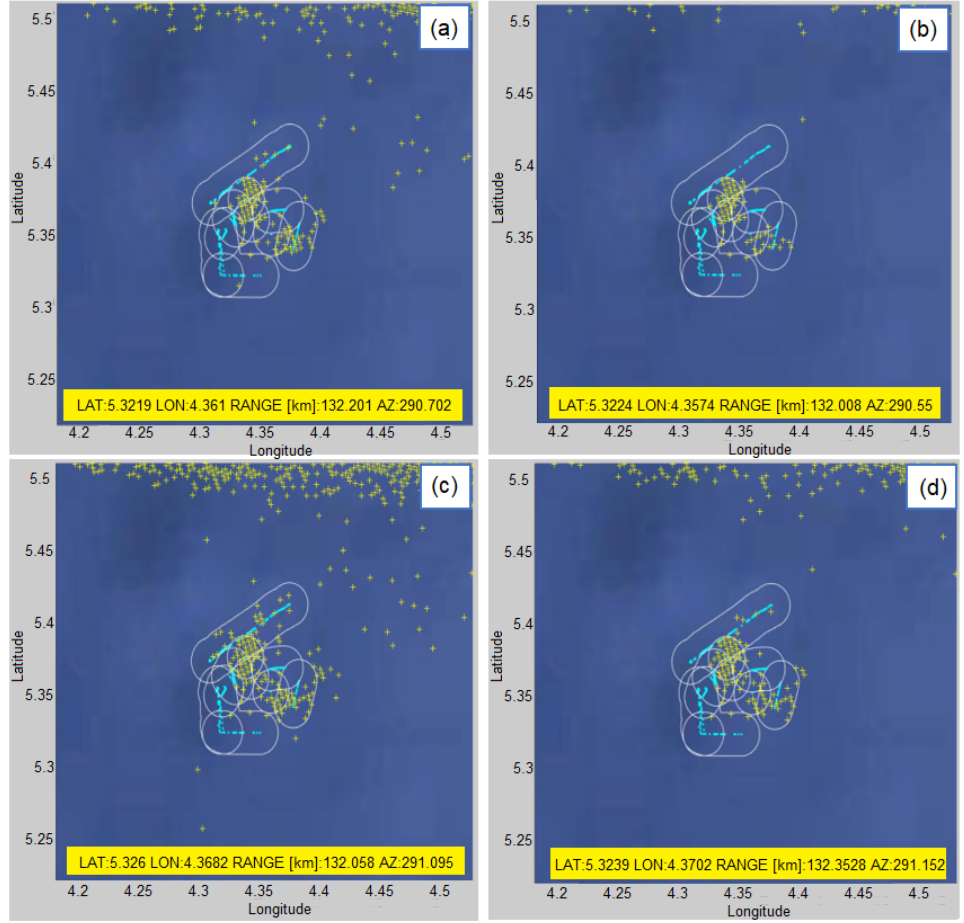
Figure 23. The display of all detections of groups of vessels with with G-123km identifier (yellow markers) with AIS data as a benchmark (light blue tracks) in a time interval of 1 h (18–19 h) for different detection parameters of the proposed algorithm: ( a ) K = 5 and normalized threshold = 0.2 ( b ) K = 5 and normalized threshold = 0.1 ( c ) K = 10 and normalized threshold = 0.2 ( d ) K = 10 and normalized threshold =